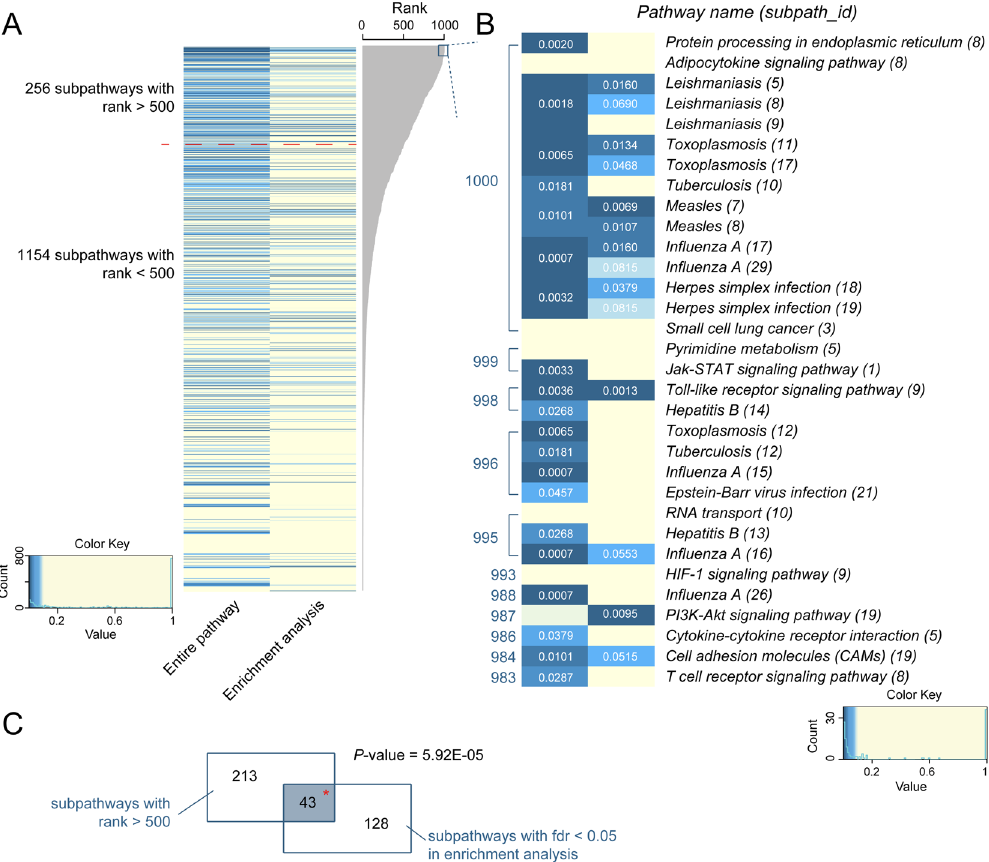
Figure 3. The analyses of melanoma prognostic subpathways. ( A ) Comparative results using sPAGM involving enrichment analyses and the entire analyses. ( B ) Detailed comparative results of subpathways with ranks > 980 in (A) . ( C ) Overlapping results between our model and the enrichment analysis